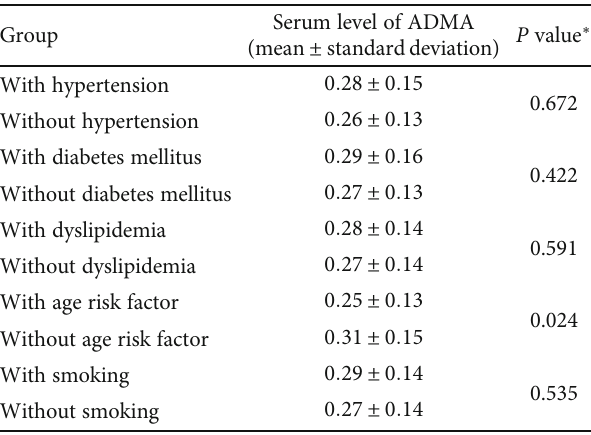
Table 2: Comparison of the serum concentration of ADMA in patients with or without cardiac risk